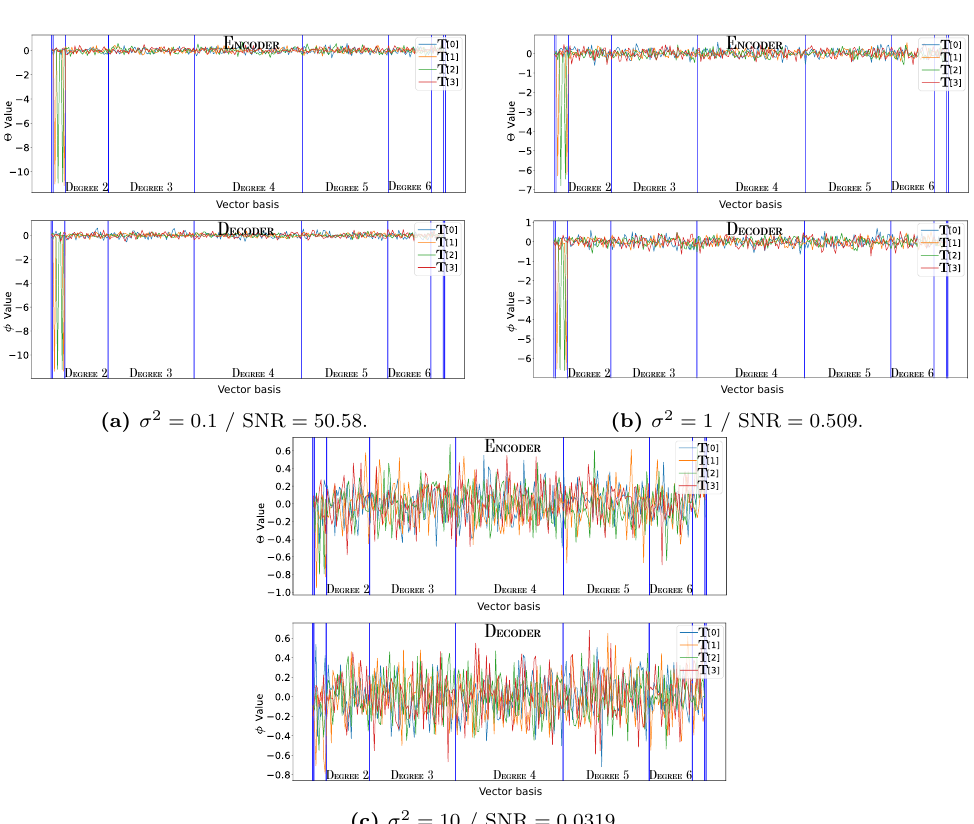
Figure 10: Weight visualization of the ˆ ψ Θ layer (encoder) and the ˆ ψ φ layer (decoder) for Scenario 2